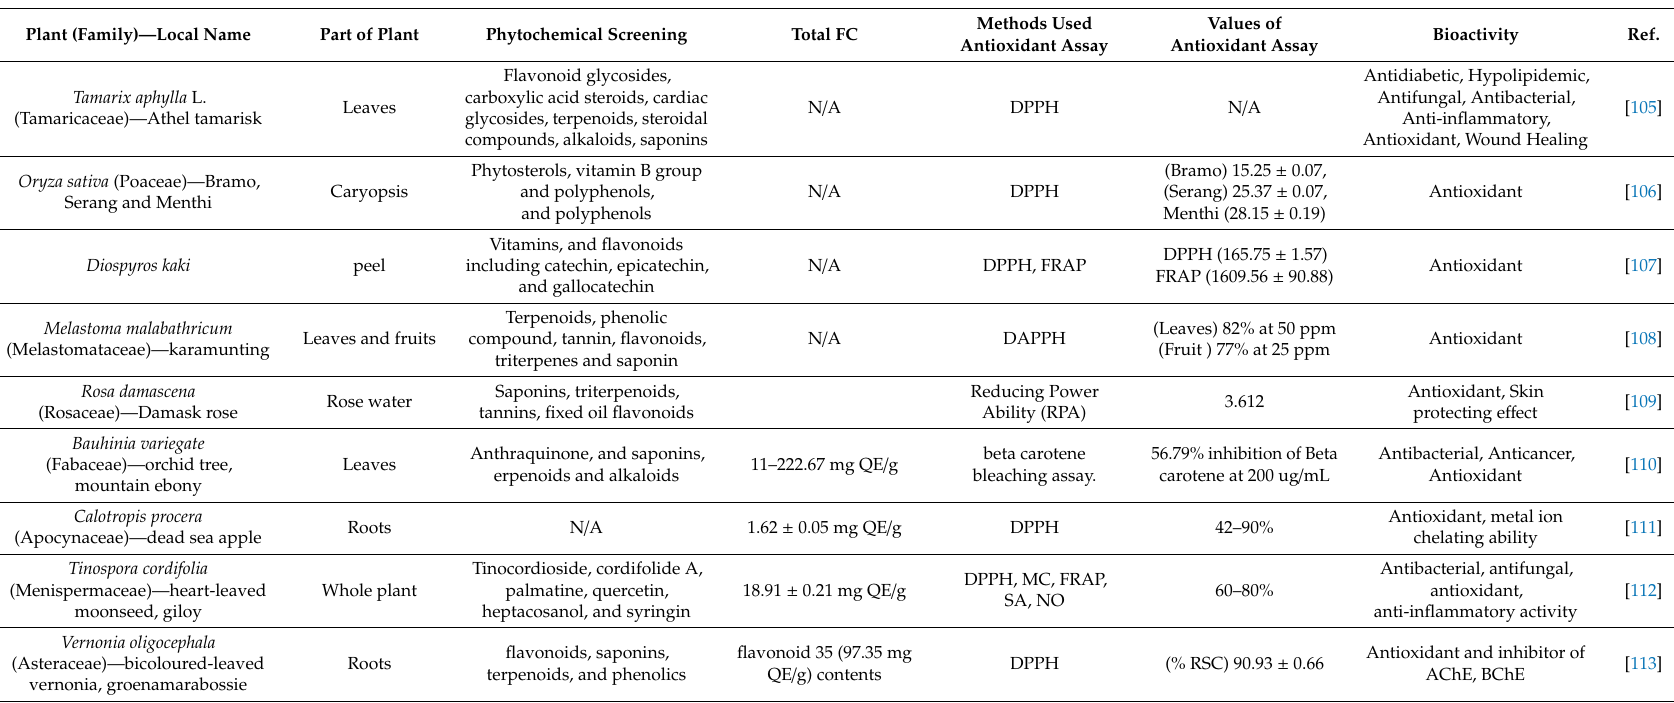
Table 2. Flavonoids having antioxidant e ff